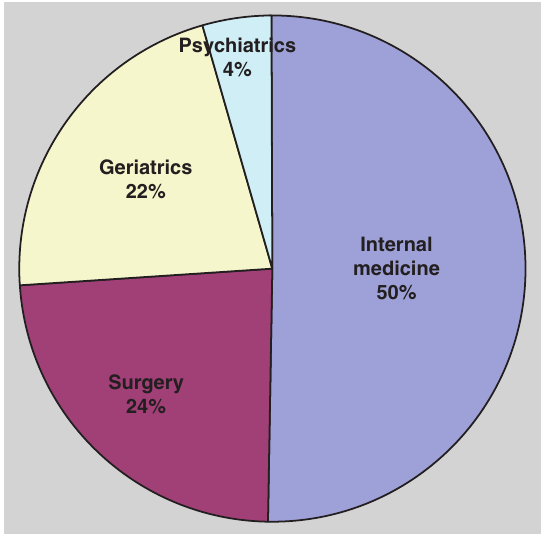
Figure 2. Relati v e contribution of each speciality to the total consumption of hospital care episodes by the multiple-diseased